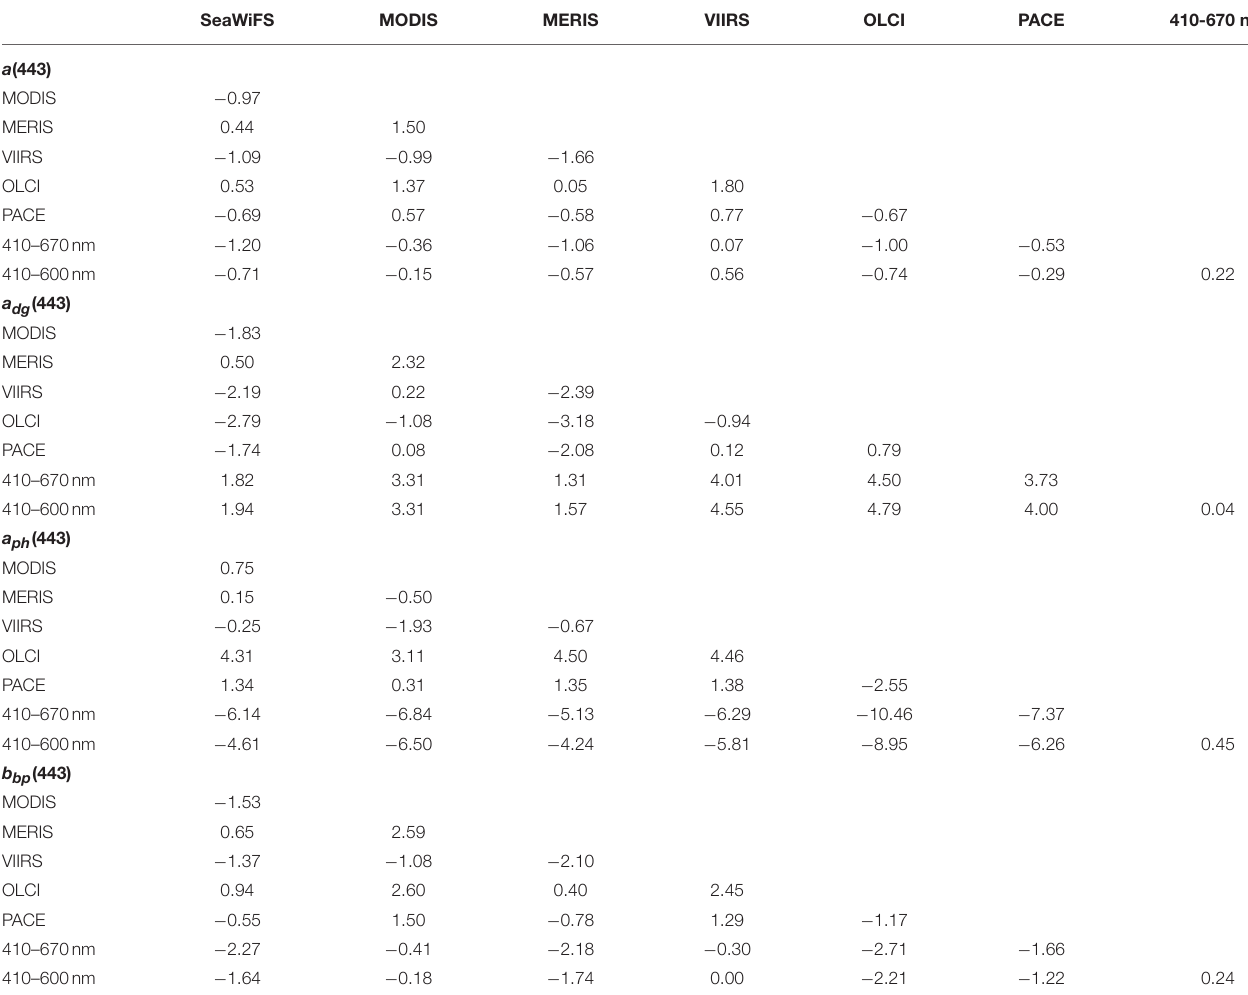
TABLE 3 | As in Table 2 , but for mesotrophic water (0.1 < C a ≤ 1.0mg m − 3 ).